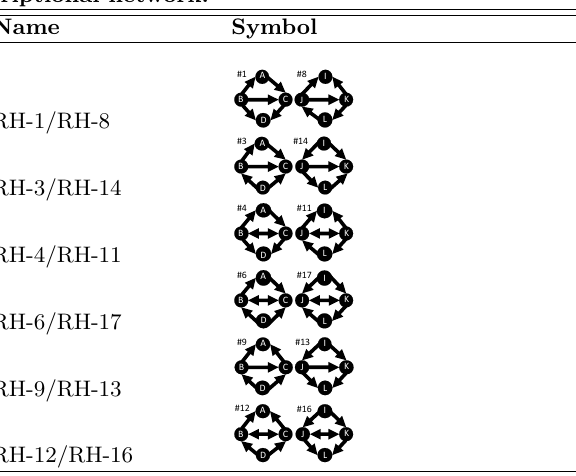
Figure 2: Mean squared errors (MSE) at different estimators for 400 network size at 90% loss. Mea- sured for the model with 38 features and 23 fea- tures respectively. Errorbars capture the variation of MSE across hundred test runs. Note that the Y-axis does not start at 0. Lower MSE is better